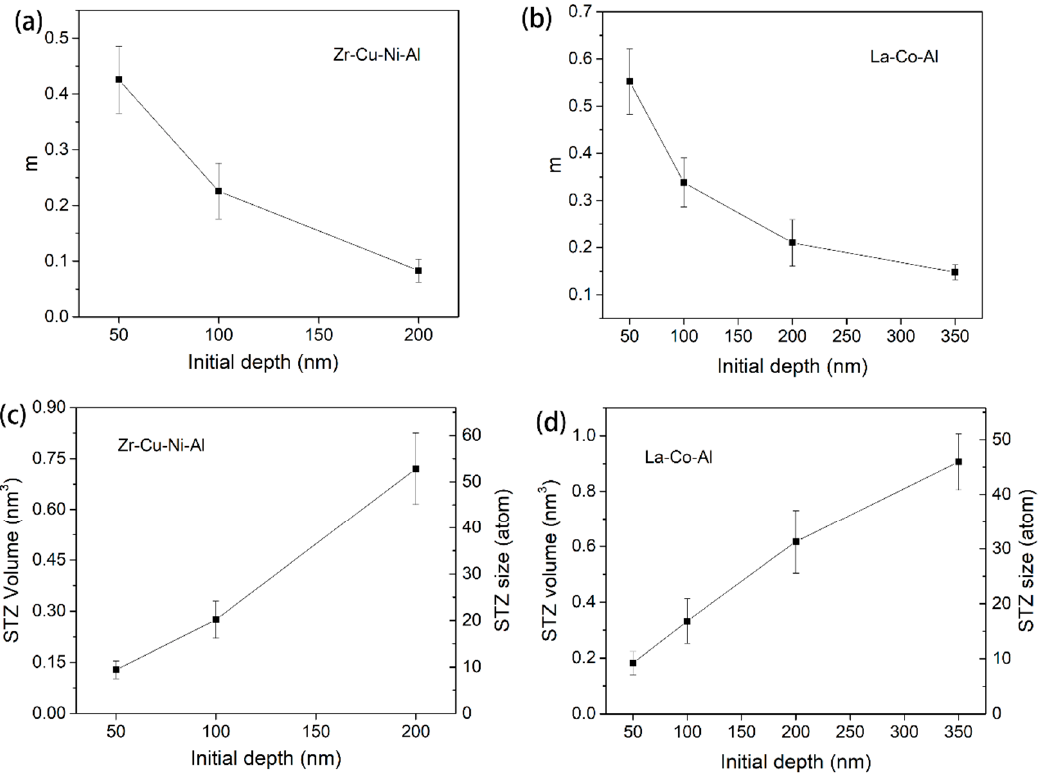
Figure 6. ( a , b ) Strain rate sensitivity, and ( c , d ) shear transformation zone (STZ) size as a function of Figure 6. ( a ),( b ) Strain rate sensitivity, and ( c ),( d ) shear transformation zone (STZ) size as a function initial holding depth for Zr-Cu-Ni-Al and of initial holding depth for Zr-Cu-Ni-Al and La-Co-Al.